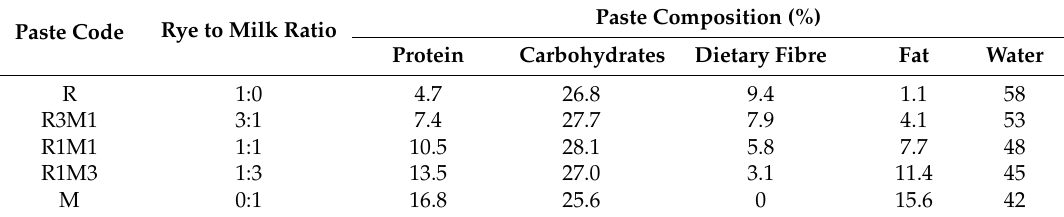
Table 1. Approximate composition of printing pastes (calculated based on raw material composition given by